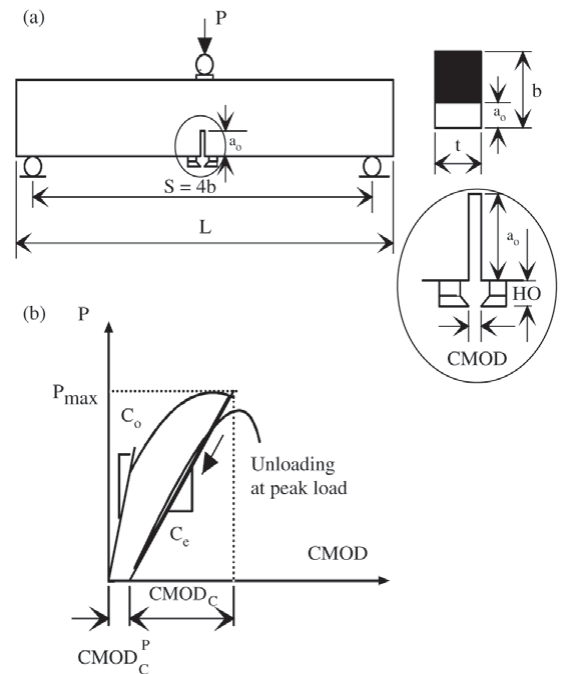
Figure 1. Testing specimen and procedure to determine the values of K ICS and CTOD C